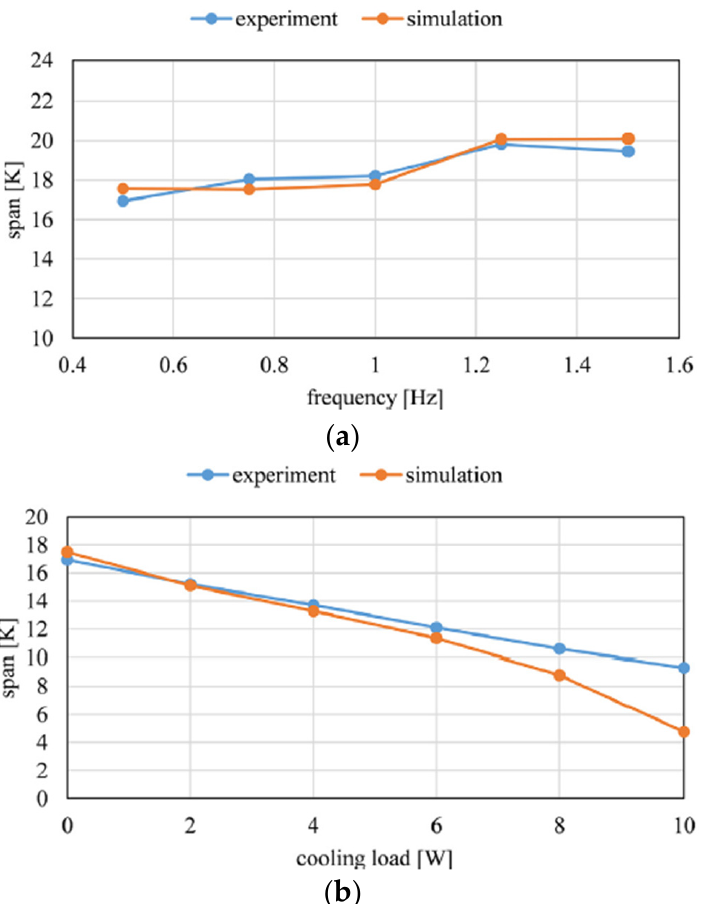
Figure 37. Experimental validation of the model by comparing the temperature range versus the: ( a ) frequency; ( b ) cooling load.